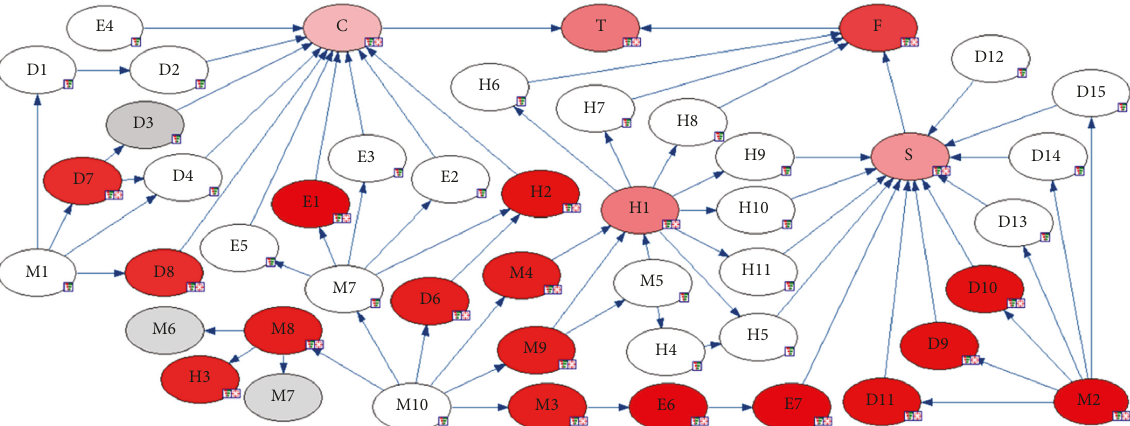
Figure 6: Sensitivity analysis of risk nodes.